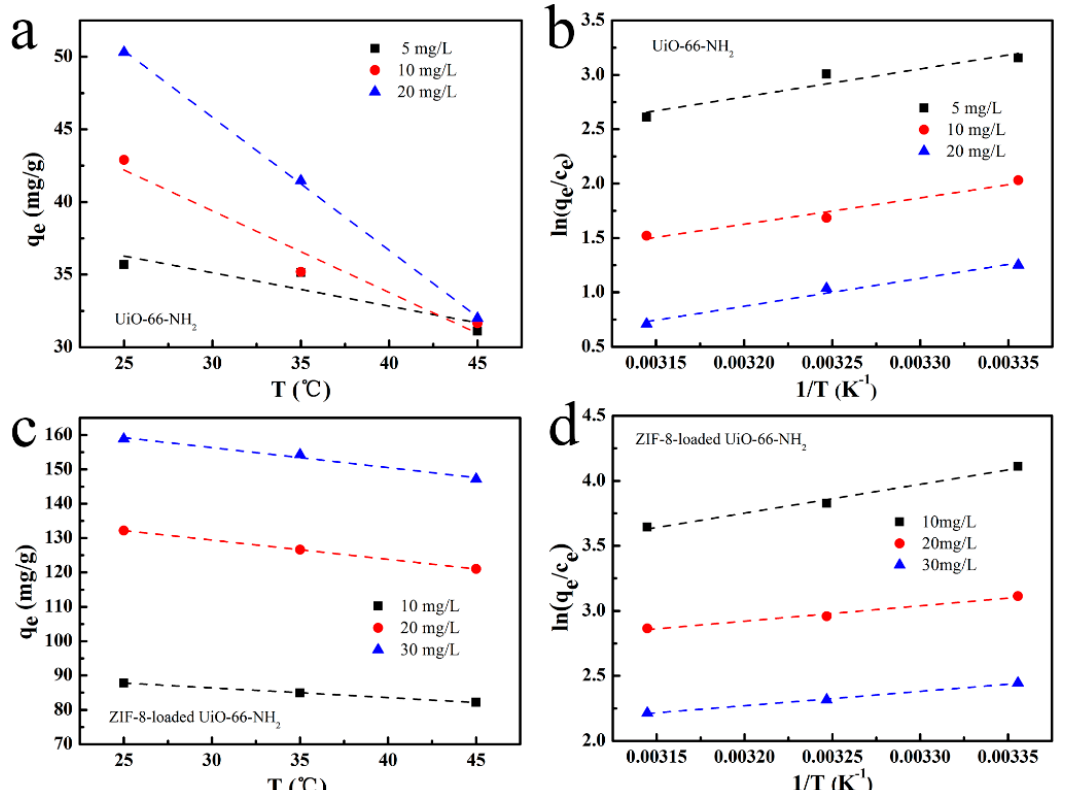
Figure 10. Effect of temperature on the adsorption capacity of methylene blue (MB) on UiO-66-NH 2 ( a ) and zeolitic imidazolate framework-8 (ZIF-8)-loaded UiO-66-NH 2 ( c ). Plots of ln(q e /c e ) versus 1/T for the adsorption of MB on UiO-66-NH 2 ( b ) and ZIF-8-loaded UiO-66-NH 2 ( d ). Table 6. Values of the thermodynamic